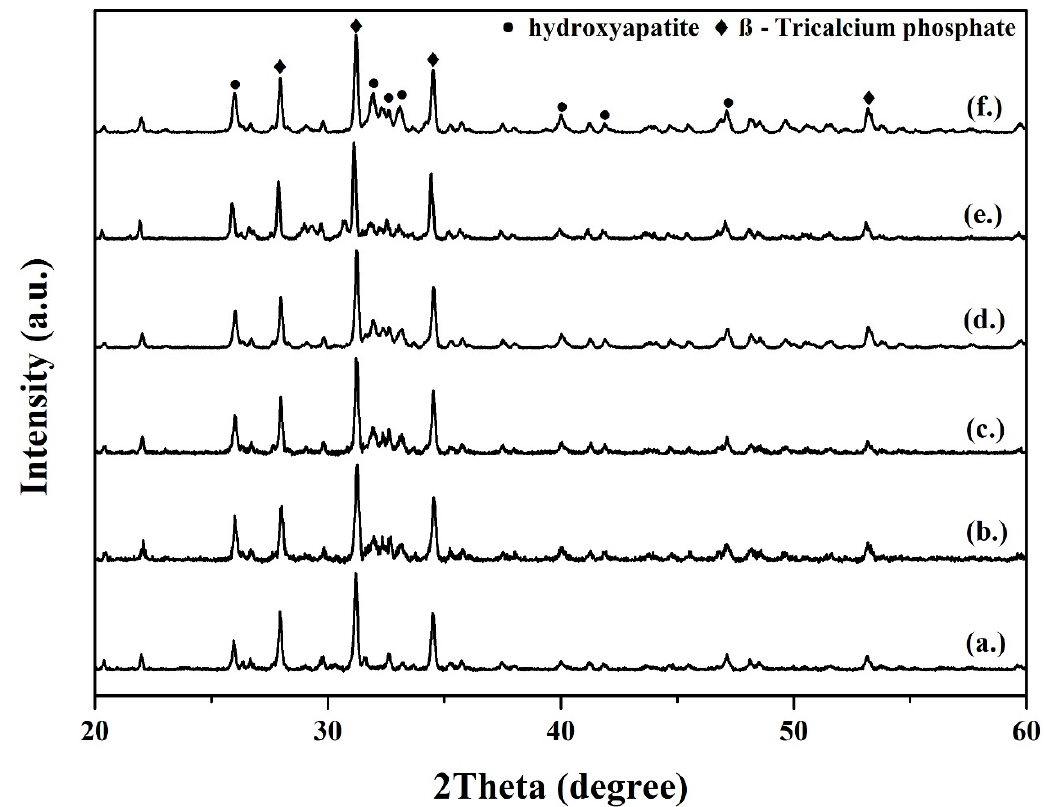
Figure 3. XRD pattern of biphasic calcium phosphate prepared by cuttlebone with variation of the CMC of L-rhamnose monohydrate biosurfactant: ( a ) no CMC, ( b ) 10 CMC, ( c ) 20 CMC, ( d ) 100 CMC, ( e ) 500 CMC and ( f ) 1000 CMC. Table 1. Crystallite size of biphasic calcium phosphate prepared by cuttlebone with a variation of the CMC of L-rhamnose monohydrate